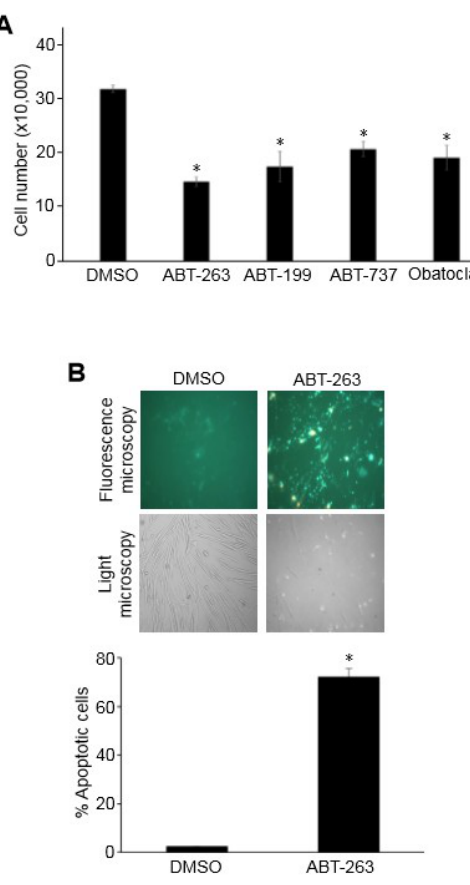
Figure 1. Bcl-2/Bcl-x L inhibition promotes the apoptosis of human pulmonary artery smooth muscle cells (PASMCs). ( A ) Human PASMCs were treated with various Bcl-2/Bcl-x L inhibitors at 1 µM for 24 h. The cell number was determined by counting on a hemocytometer. An equal amount of dimethyl sulfoxide (DMSO; 0.1%) was used as a vehicle control. The symbol * denotes that the value was significantly different from the DMSO control at p < 0.05 (n = 3). ( B ) Human PASMCs were treated with ABT-263 (1 µM) for 24 h. Apoptotic cells were assessed by a fluorescence-based assay that measured phospholipid phosphatidylserine by staining with an EGFP fusion of annexin V. The symbol * denotes that the value was significantly different from the DMSO control at p < 0.05.